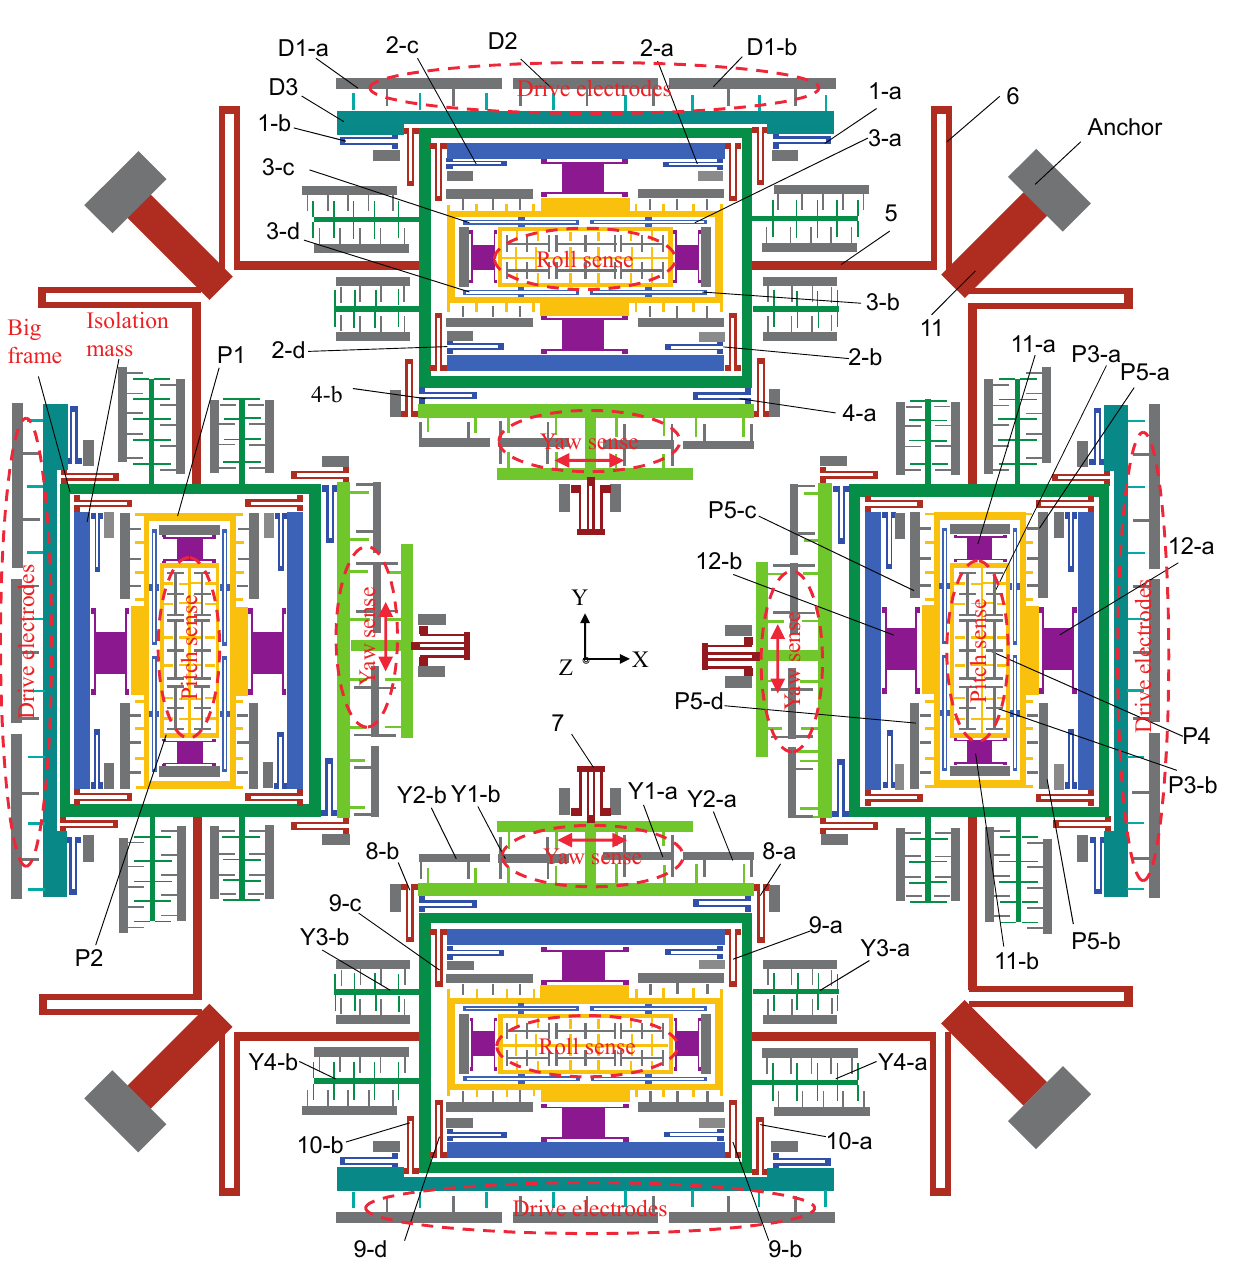
Figure 1. Schematic of the proposed vibratory tri-axis gyroscope. (1) Drive mode springs: U-shaped spring-1, spring-2, spring-4, double-U-shaped spring-3, crab-leg spring-5; D1: driving electrodes; D2: drive-sense electrode; D3: drive beam. (2) Yaw mode springs: U-shaped spring-6, spring-8, spring-9, spring-10 and double folded spring-7; Y1: yaw-sense electrodes; Y2: feedback electrode in yaw mode; Y3: frequency tuning electrodes in yaw mode; Y4: quadrature error correction electrodes in yaw mode; (3) Pitch/roll mode springs: out-of-plane decoupling spring-11 and spring-12; P1: outer frame in roll mode; P2: inner frame in pitch mode; P3: pitch-sense electrodes; P4: feedback electrode in pitch mode; P5: quadrature error correction electrodes in pitch